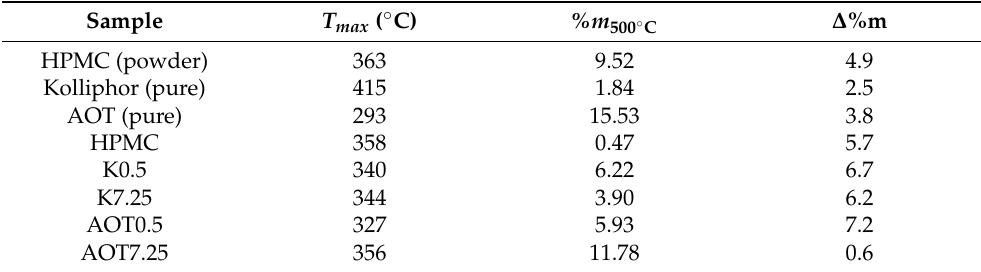
Table 4. Maximum thermal decomposition temperature ( T max ), percentage in residual mass at 500 ◦ C (% m 500 ◦ C ), and difference of mass ( ∆ %m) between 30 ◦ C (% m 30 ◦ C ) and 100 ◦ C (% m 100 ◦ C ) determined for HPMC (powder), pure Kolliphor, pure AOT, HPMC, K0.5, K7.25, AOT0.5, and AOT7.25 cryogels. Sample T max ( ◦